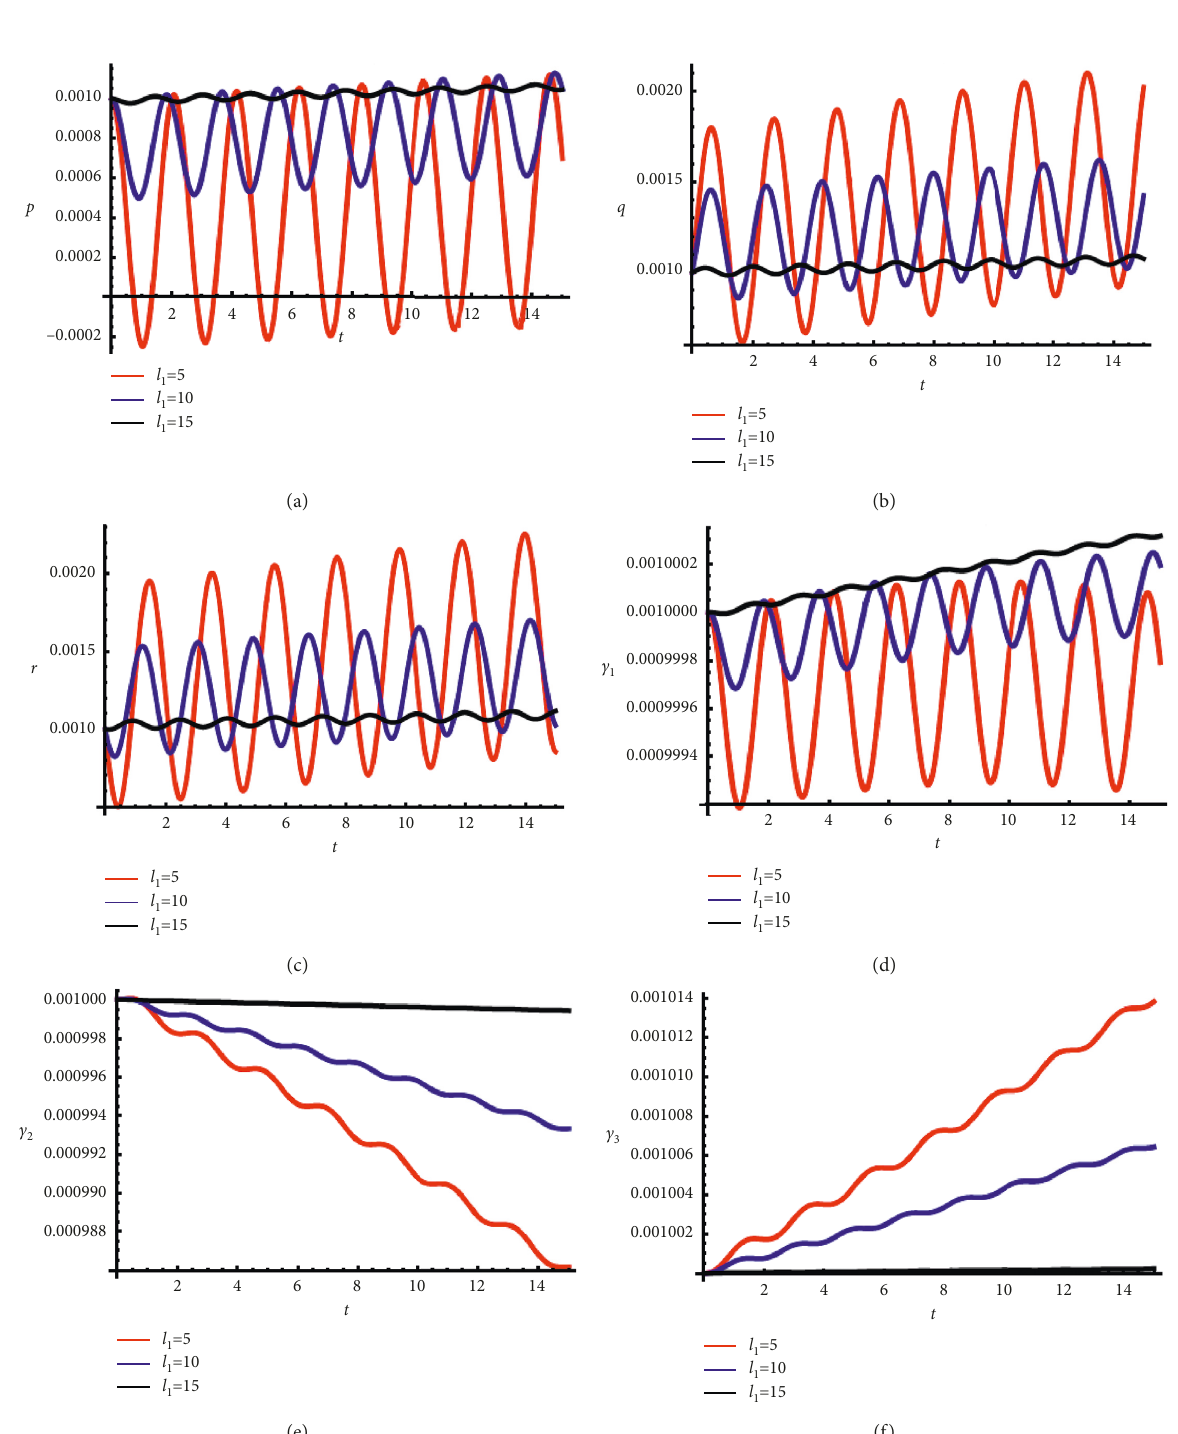
Figure 2: Variation of the numerical solutions of p, q,r, c